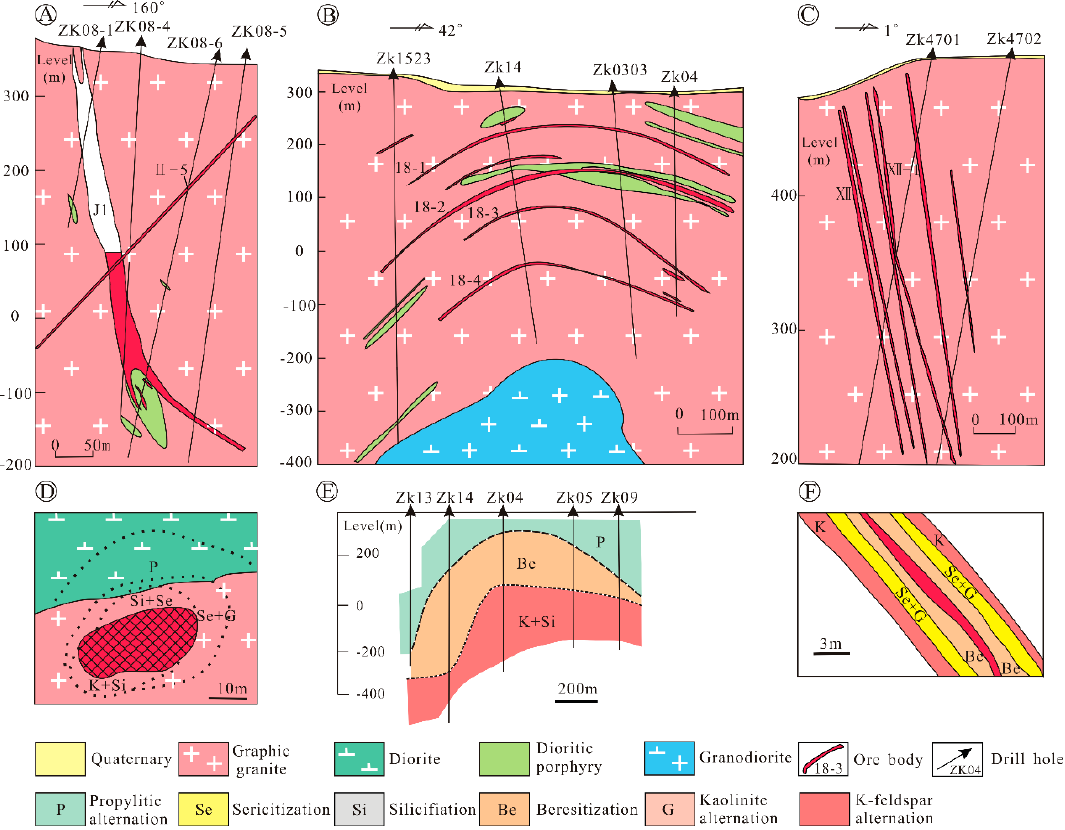
Figure 3. Geological sections and alteration patterns of the ore bodies (modified after Zhang et al. [19]); ( A ) geological cross-section of the J-1 ore body; ( B ) geological cross-section of the No. 18 ore